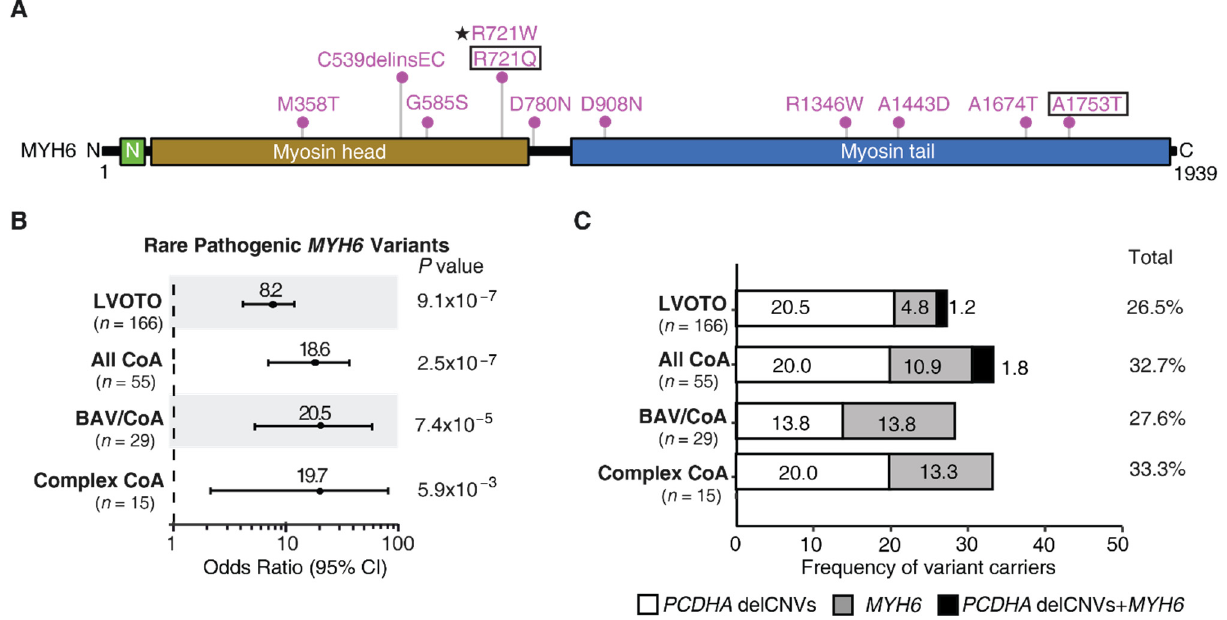
Figure 1. Rare pathogenic MYH6 variants enriched in LVOTO cohort. ( A ) Pathogenic MYH6 variants identified in Pittsburgh cohort. Variants R721Q and A1753T (with black box) were found in the same patient. The Icelandic R721W variant is indicated with a star. ( B ) Burden analysis yielded odds ratio indicating significant excess of rare pathogenic MYH6 variants associated with CoA and other related LVOTO. p values were obtained by Fisher’s exact test. 95% CI: 95% confidence interval. ( C ) Proportion of subjects with PCDHA delCNVs (16.8 kb/13.6 kb) and/or pathogenic MYH6 variants among LVOTO in Pittsburgh cohort.